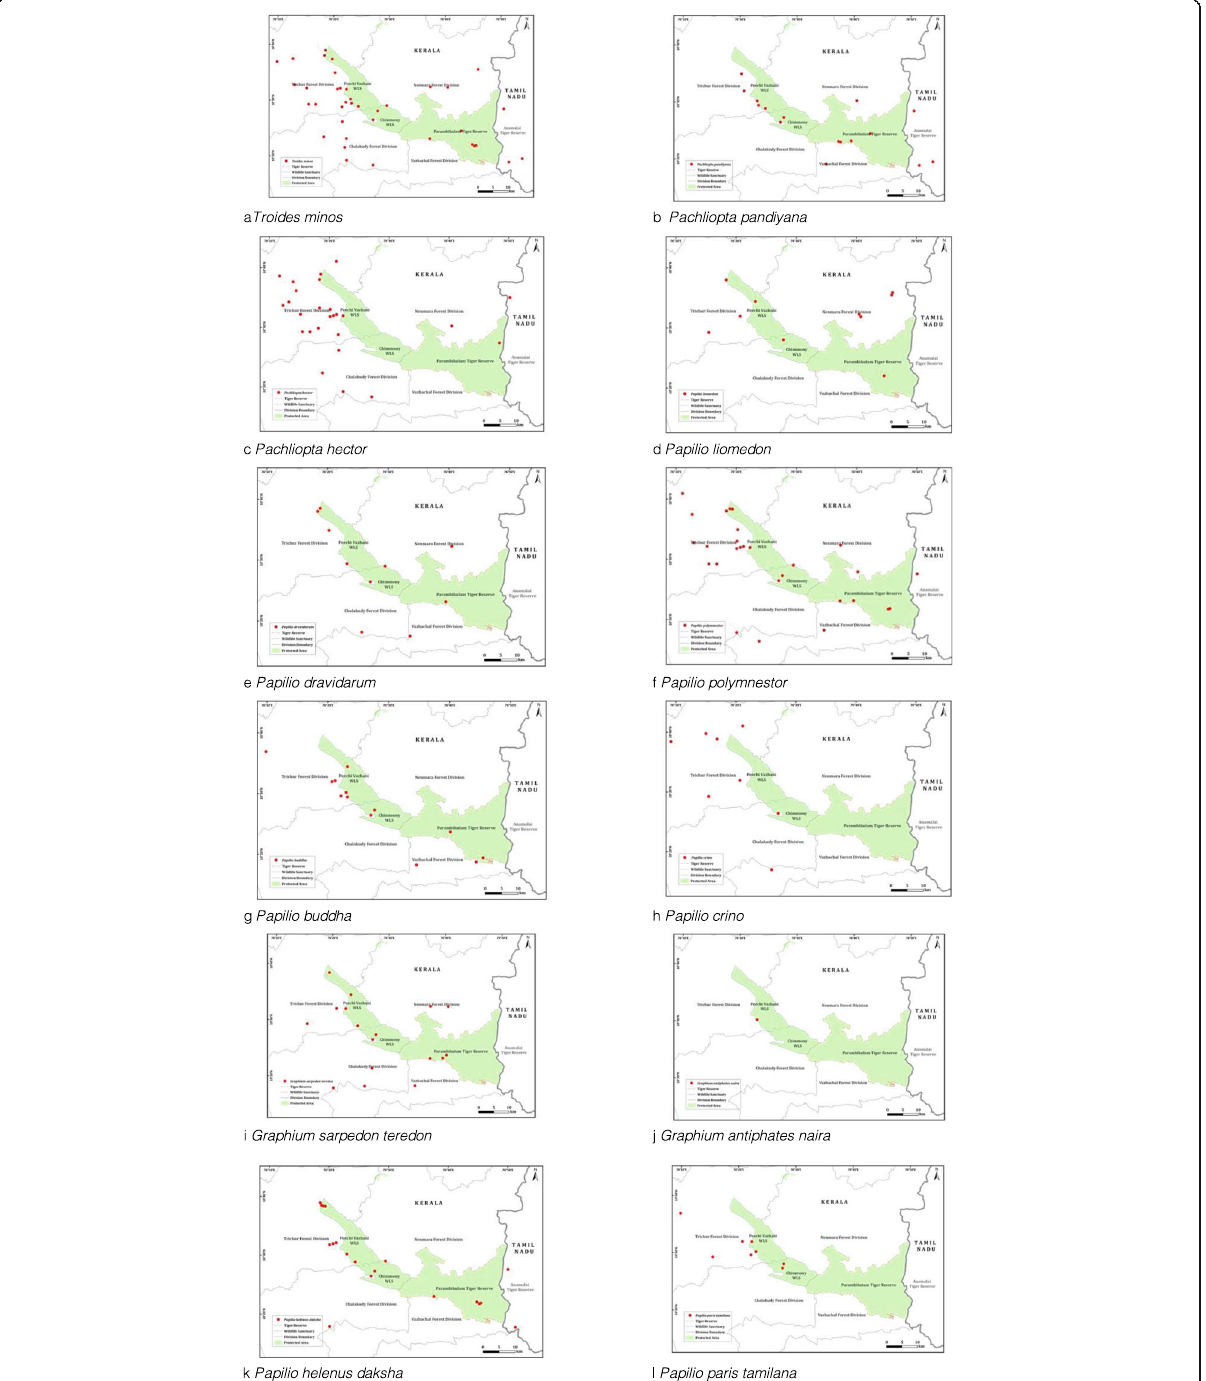
Fig. 3 a - l Distribution maps of endemic butterflies of family Papilionidae within study area. a Troides minos . b Pachliopta pandiyana . c Pachliopta hector . d Papilio liomedon . e Papilio dravidarum . f Papilio polymnestor . g Papilio buddha . h Papilio crino . i Graphium sarpedon teredon . j Graphium antiphates naira . k Papilio helenus daksha . l Papilio paris